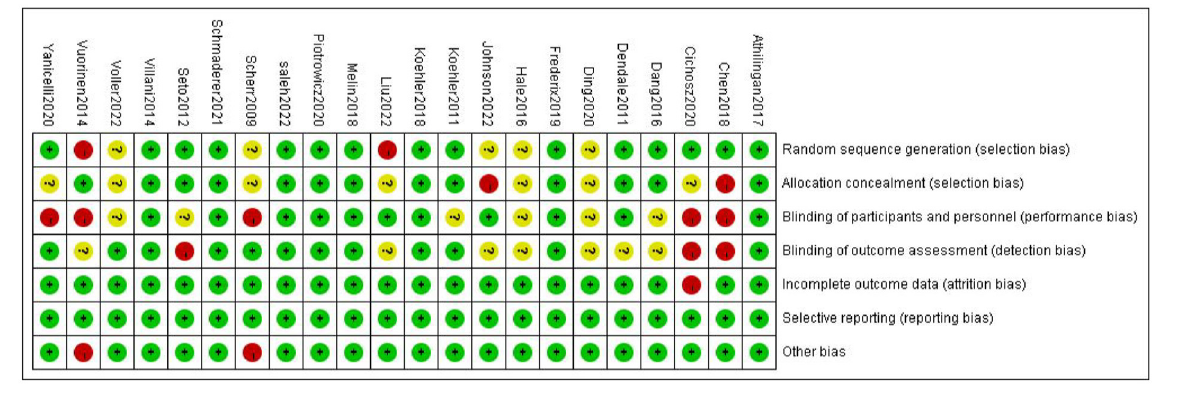
FIGURE3 Risk of bias summary.